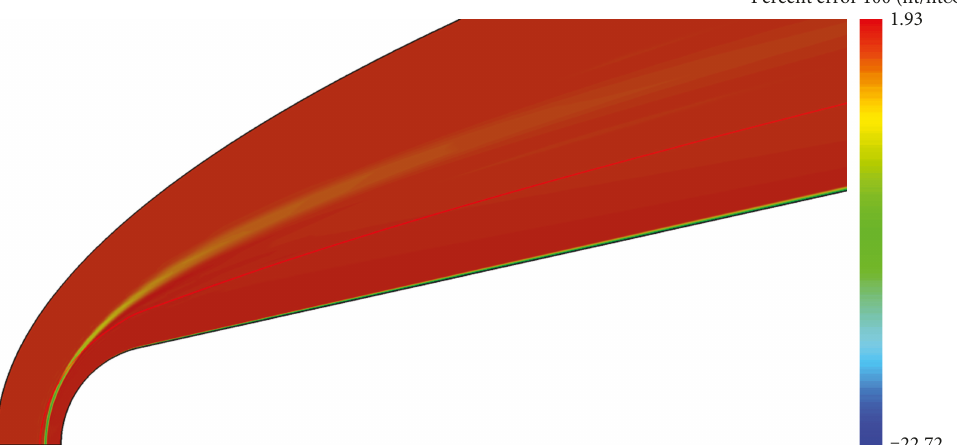
Figure 10: Total enthalpy percent error (ht/ht ∞ -1)% (model R3).